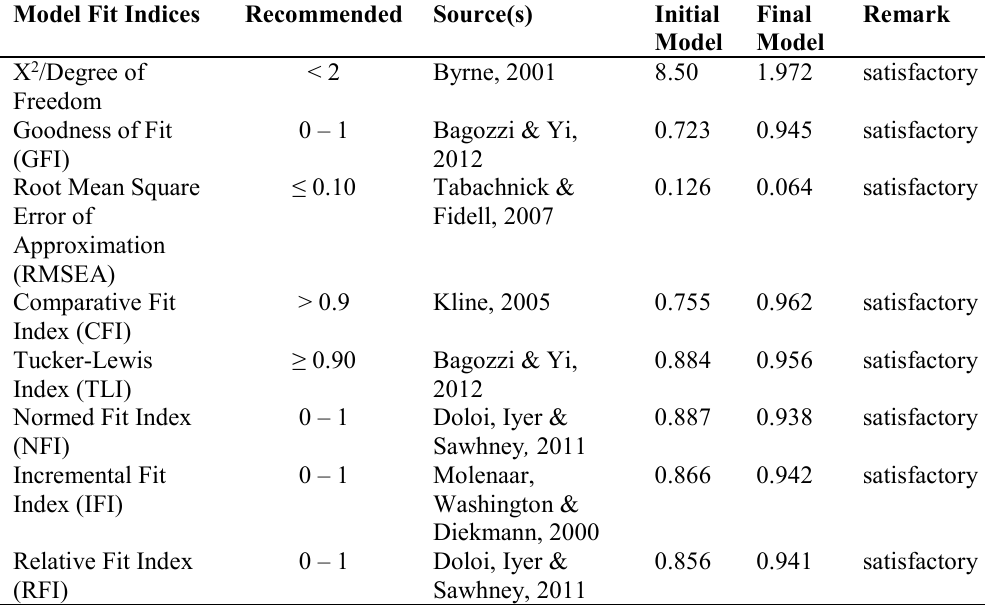
Table 1. Model Fit Indices (developed by the authors)